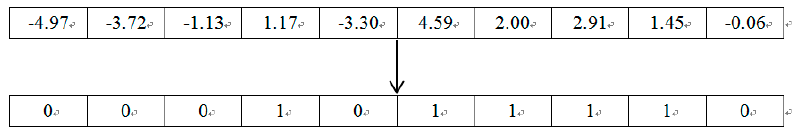
Algorithm 3. Global Position Updating Operator